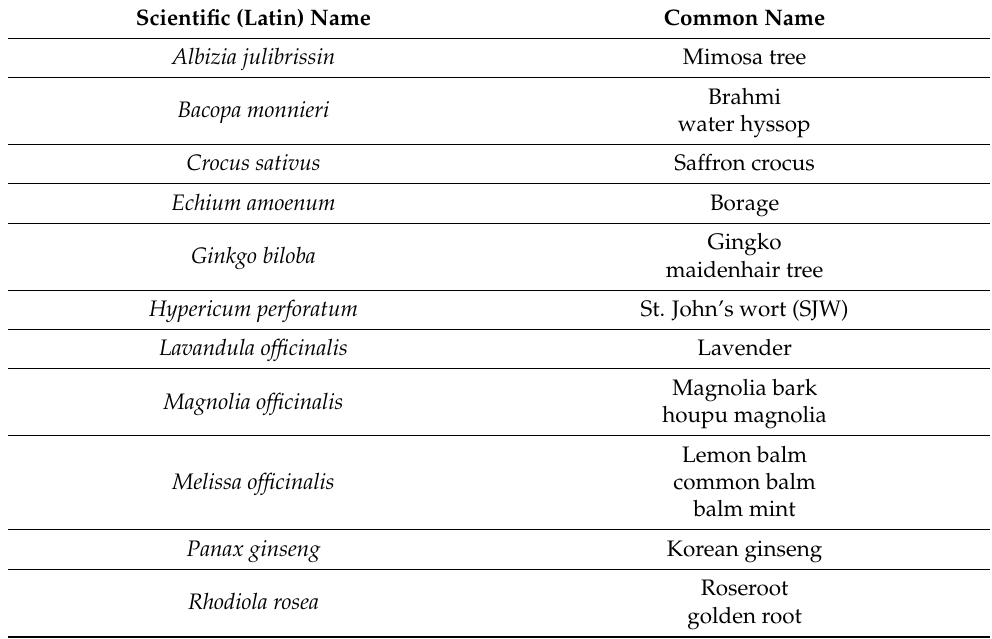
Table 3. Latin and common names of medicinal plants whose antidepressant properties are discussed in this review (in alphabetical